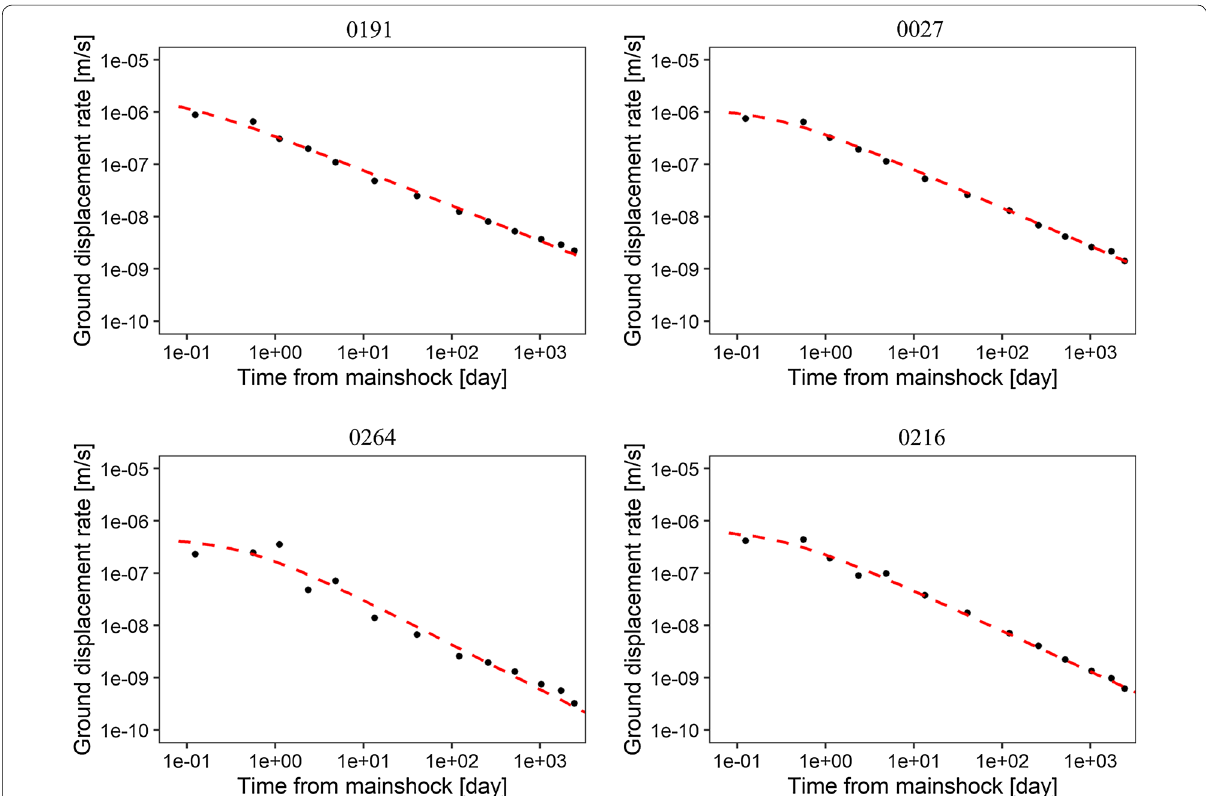
Fig. 4 Evolution of the horizontal ground displacement rates after the 2011 Tohoku Earthquake at representative GNSS stations (Fig. 1). The red dashed lines represent the best-fit based on Eq.